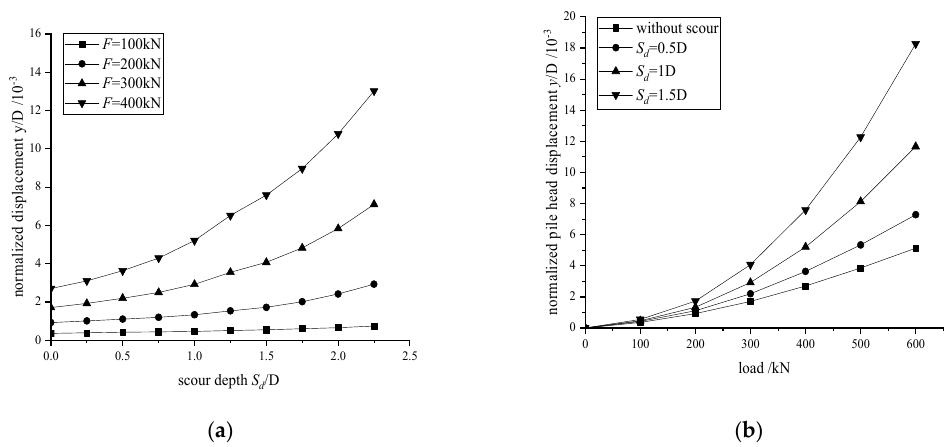
Figure 13. P–y curve under different depths.